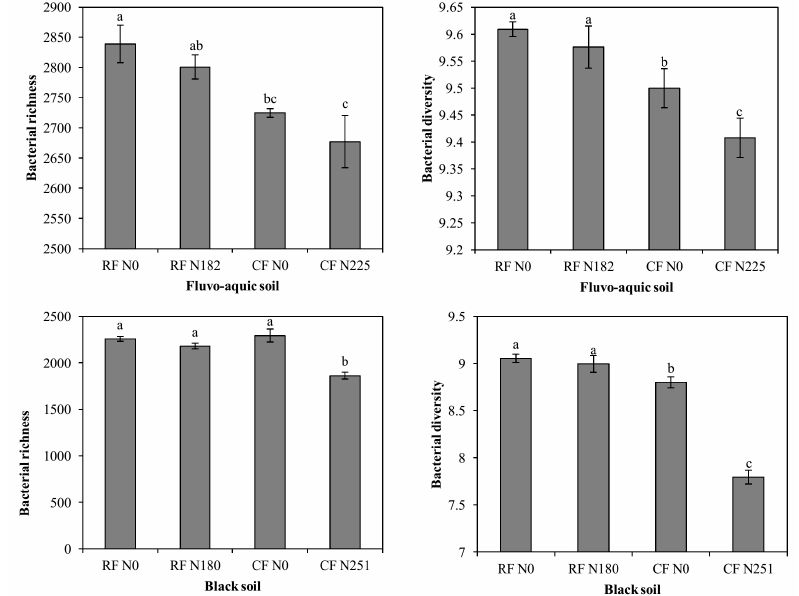
Figure 2. Comparison of estimated alpha diversity indices of 16s rRNA gene libraries for clustering at 97% similarity, obtained from high throughput sequencing analysis. Data are the means, n = 4, error bars represents standard error. Bars with the same letter are not significantly different at p ≤ 0.05.